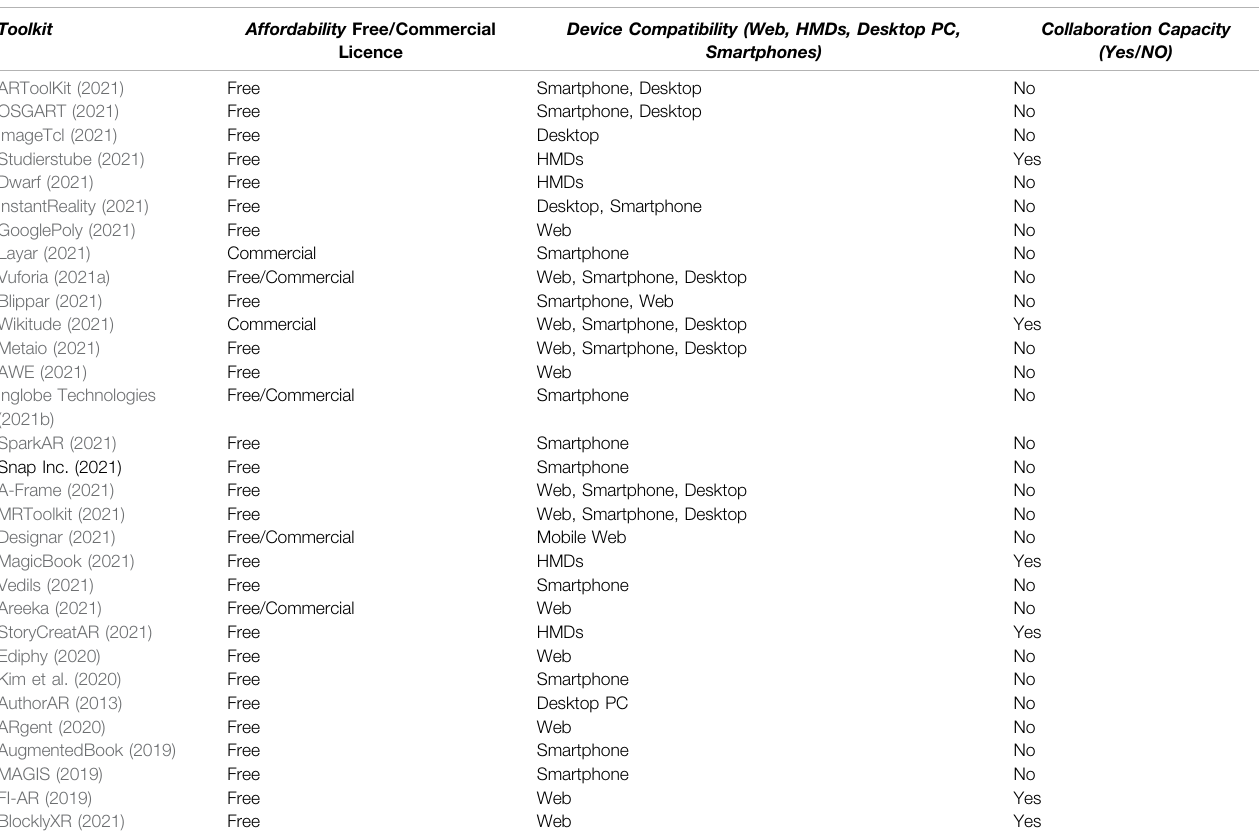
TABLE 4 | Analysis of authoring tools according to affordability (cost), device compatibility, collaboration capacity.